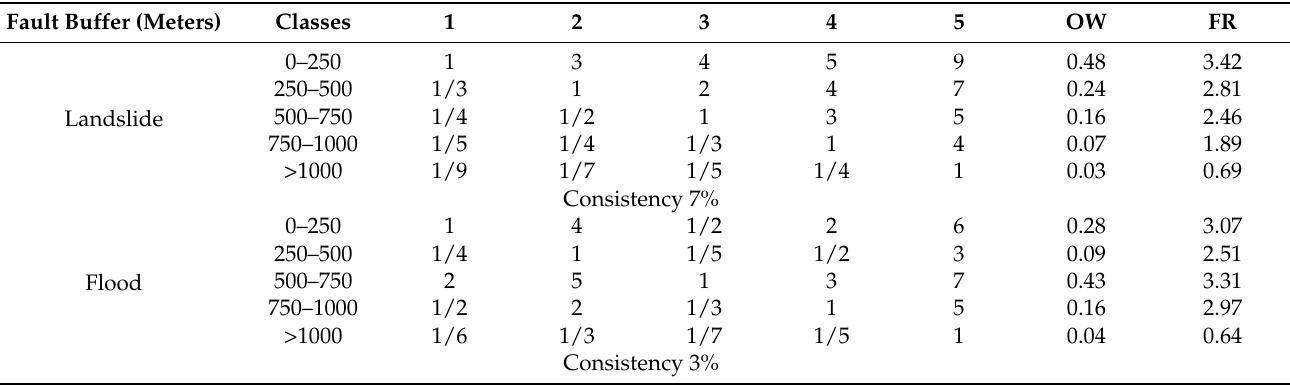
Figure 10. Structure causative factor map. Table 11. AHP matrices and OWs for the road causative factor